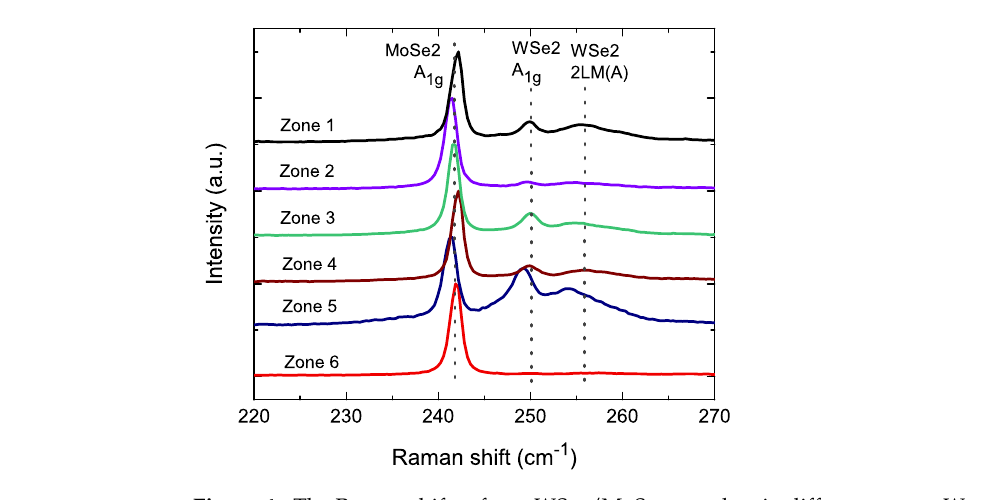
Figure 4. The Raman shifts of two WSe 2 /MoSe 2 powders in different zones. We exhibit the standard peaks of WSe 2 and MoSe 2 . Red shifts of WSe 2 peaks are shown in zone 5.